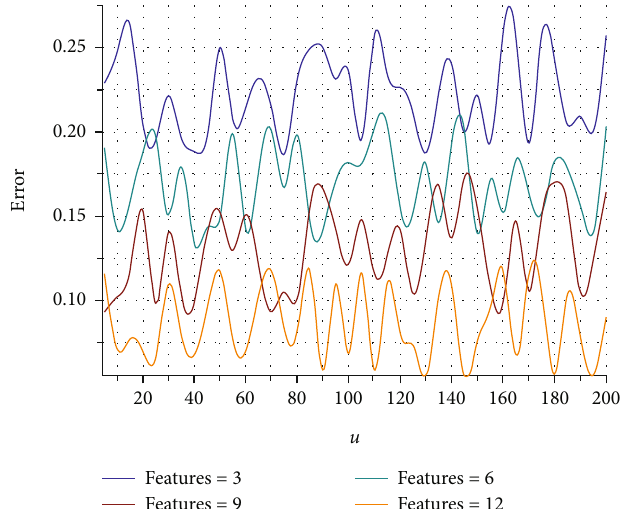
Figure 7: Error for the varying u and features.